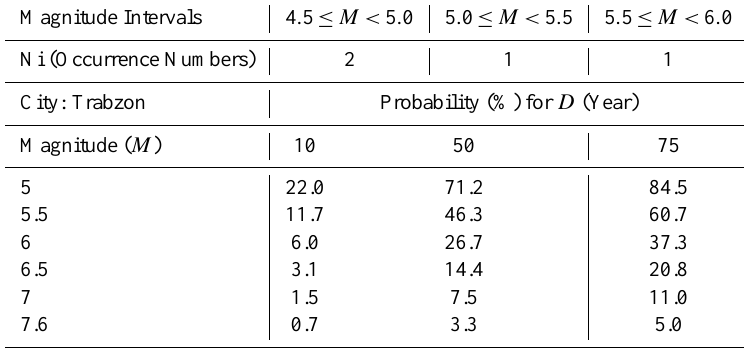
Table 3u. Earthquake occurrence probability (%) for D (Year) for Trabzon city.